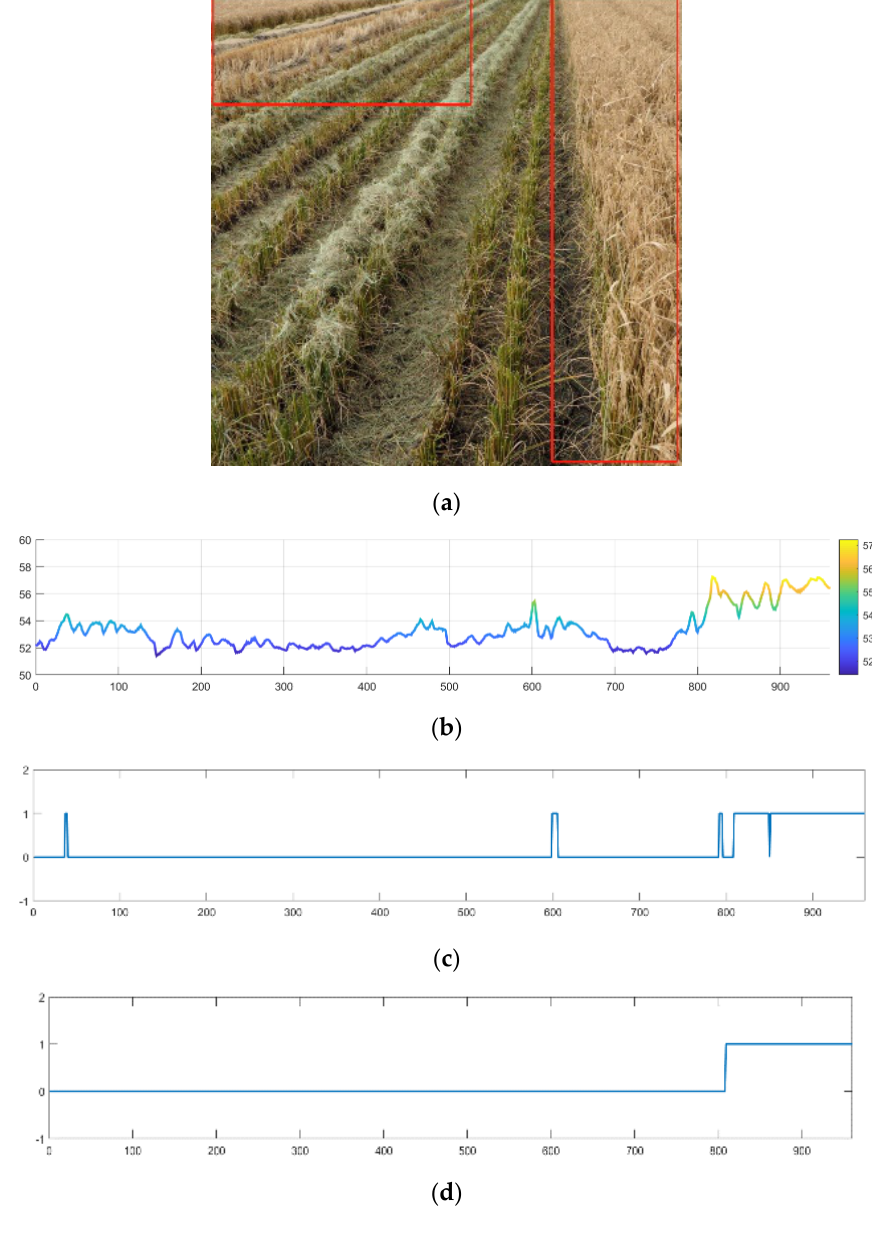
Figure 4. Target crop row selection process: ( a ) Image to be processed; ( b ) Projected results; ( c ) Results after shaping; ( d ) Noise reduction results.